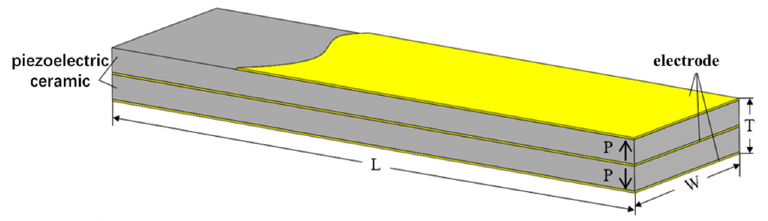
Figure 1. Rectangular double-laminated geometry.